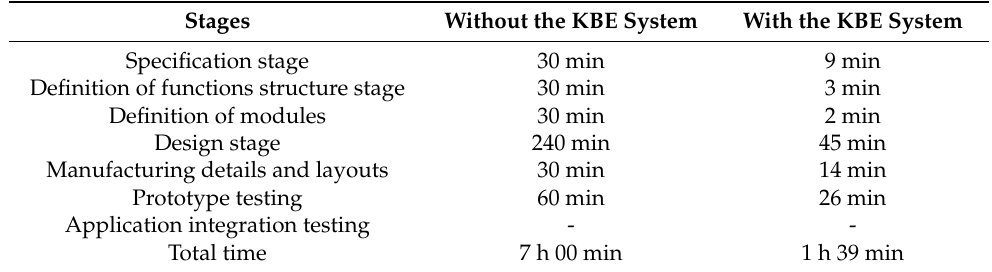
Table 1. Working time consumption comparison between expert using and not using the KBE system. Stages Without the KBE System With the KBE System Specification stage 30 min Definition of functions structure stage Definition of modules Design stage Manufacturing details and